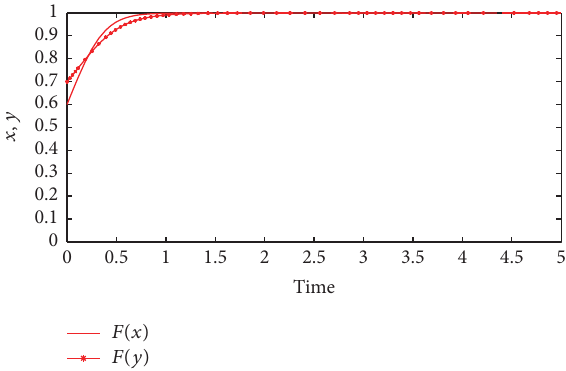
Figure 6: The equilibrium figure after 3rd step